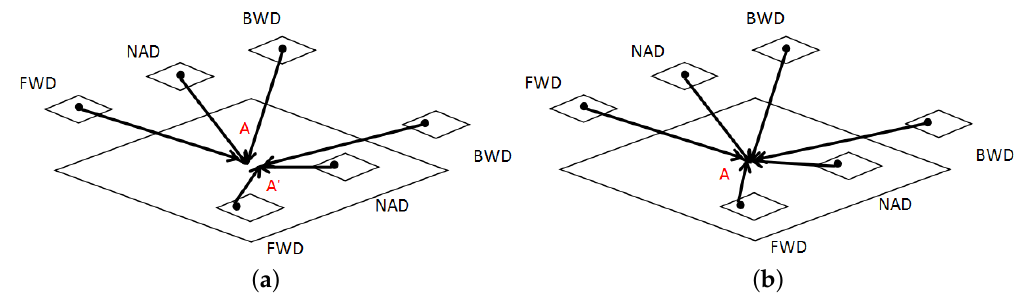
Figure 3. Comparison of ( a ) tie point pair and ( b ) tie point set. A and A (cid:48) are different observations of the same object at different times. FWD, BWD, and NAD are the ZY-3 satellite images from the forward-, backward-, and nadir-directed cameras, respectively, for the same